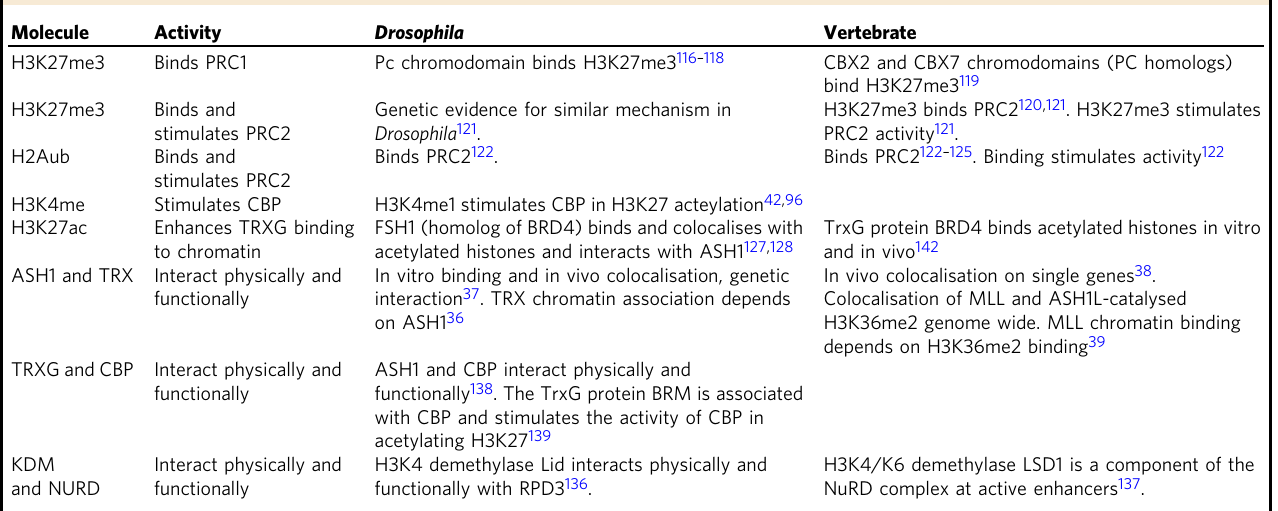
Table 2 Self- reinforcing interactions Molecule